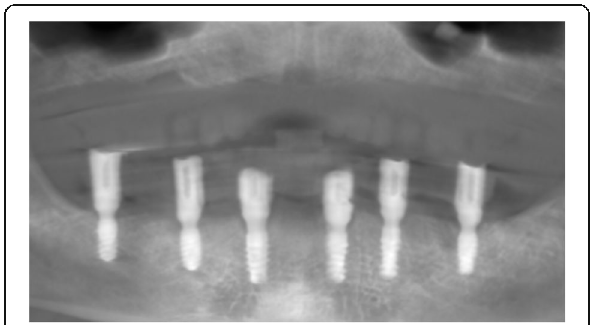
Fig. 15 Panoramic radiograph after implant